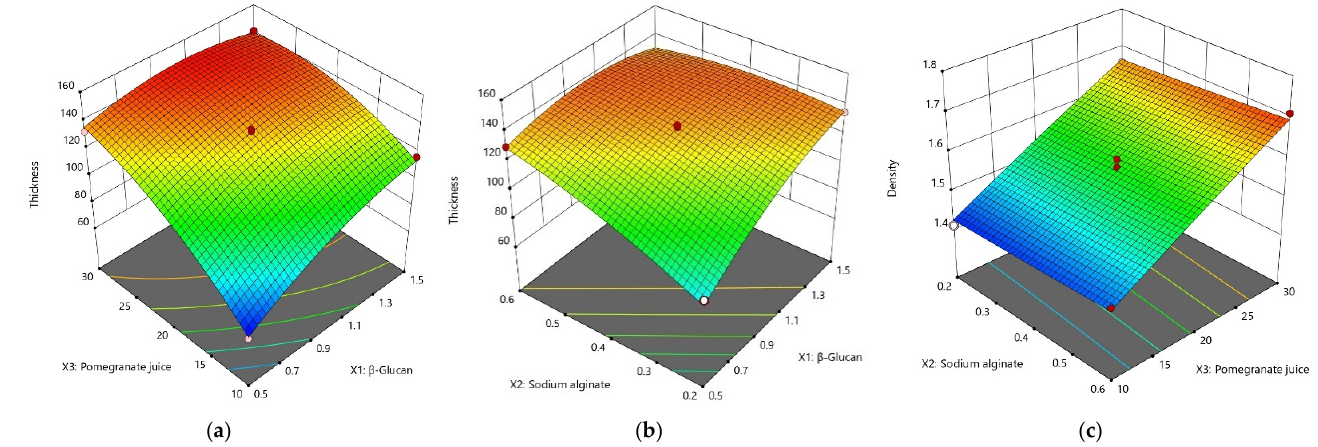
Figure 1. 3-D plots for the effect of independent variables on the film thickness and density. ( a ) Effect of β –glucan and PJ on the film thickness; ( b ) Effect of SA and β –glucan on the film thickness; ( c ) The effect of SA and PJ on density of films .